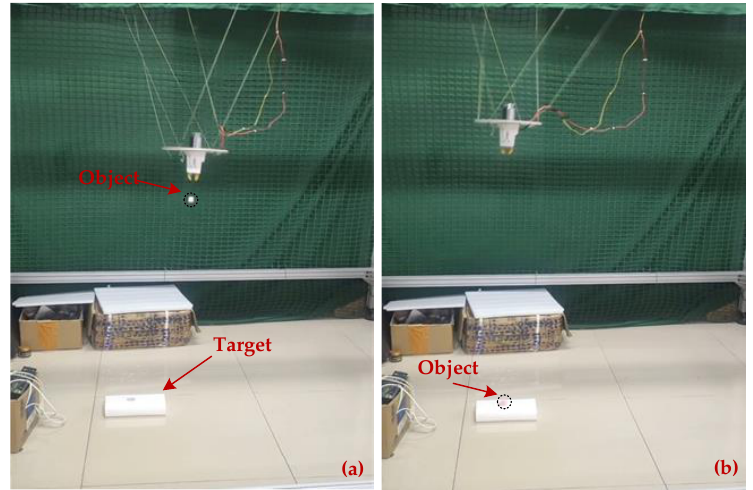
Figure 14. An example launch: the gripper mounted on the EE opens and the carried object is released (frame ( a )). The object then moves towards the target along a parabolic trajectory ( b